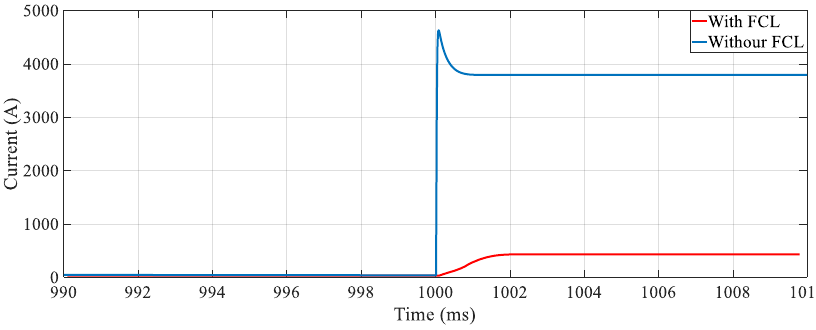
Figure 13. Fault current with and without FCL.